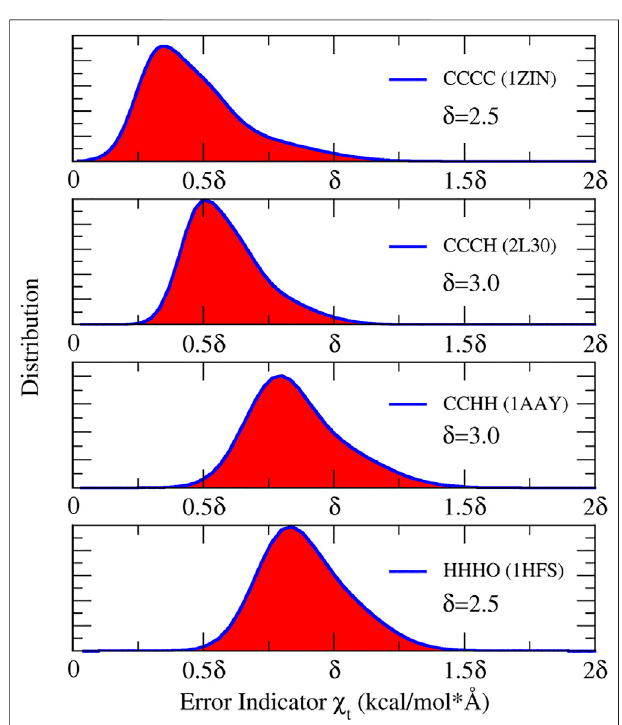
FIGURE4| Thedistributionoferrorindicator χ t inthefourrepresentative systems. The unit of δ is kcal / ( mol · ˚ A